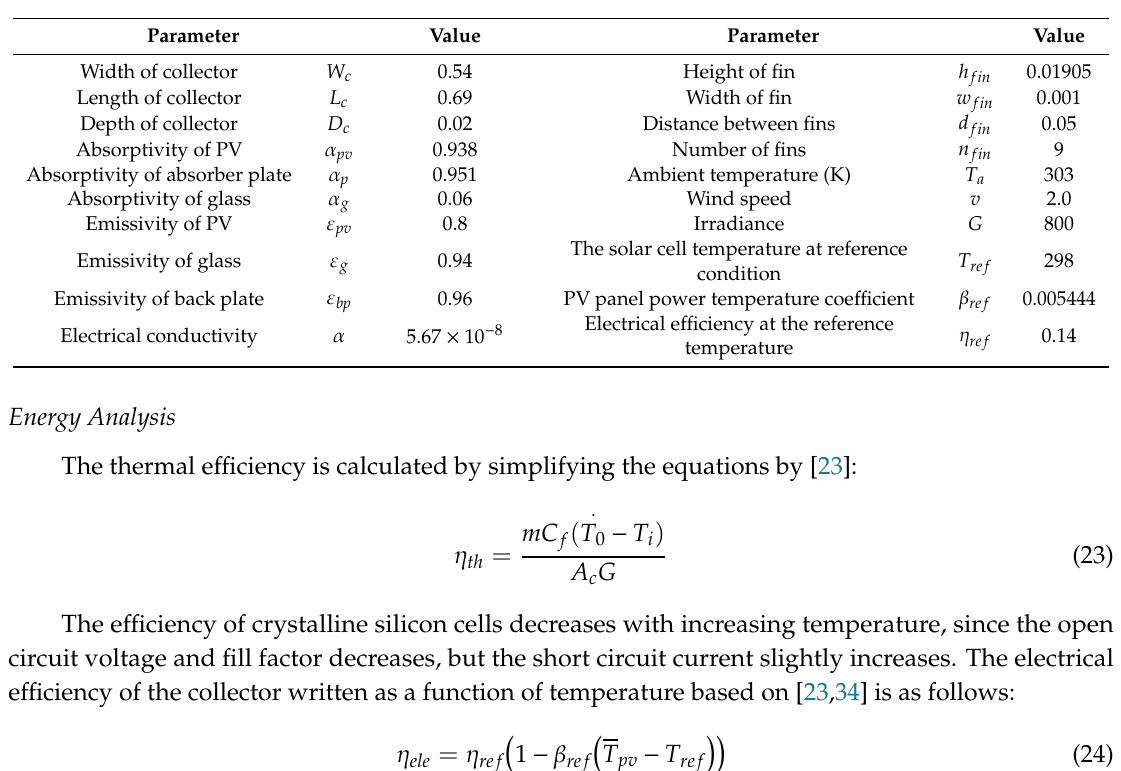
Table 1. Values of coe ffi cients and ambient conditions used in the